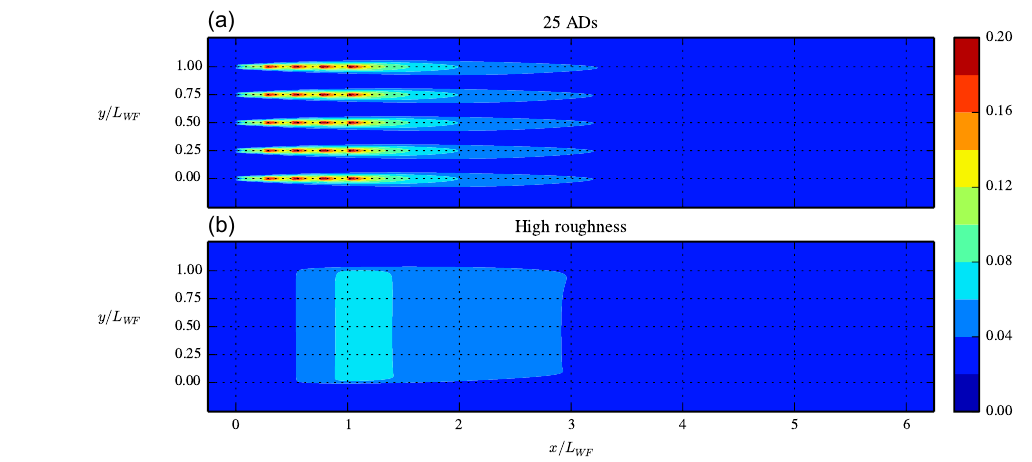
Figure 5. Turbulence intensity at hub height. (a) Wind farm modeled with 25ADs. (b) Wind farm modeled as a high roughness.